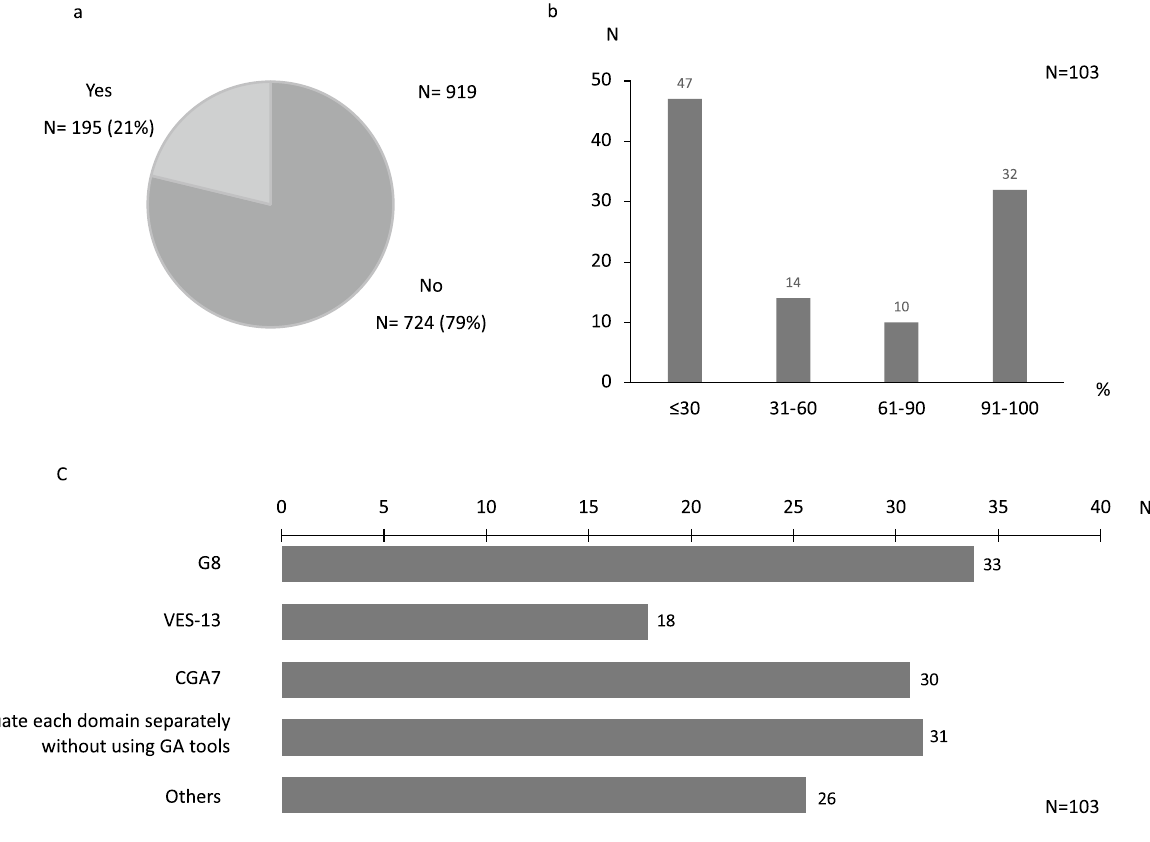
Figure 1. GA recognition and implementation rates, and assessment tools. ( a ) GA recognition rate. ( b ) GA implementation rate. ( c ) GA evaluation tools. (Multiple responses accepted). GA geriatric assessment.